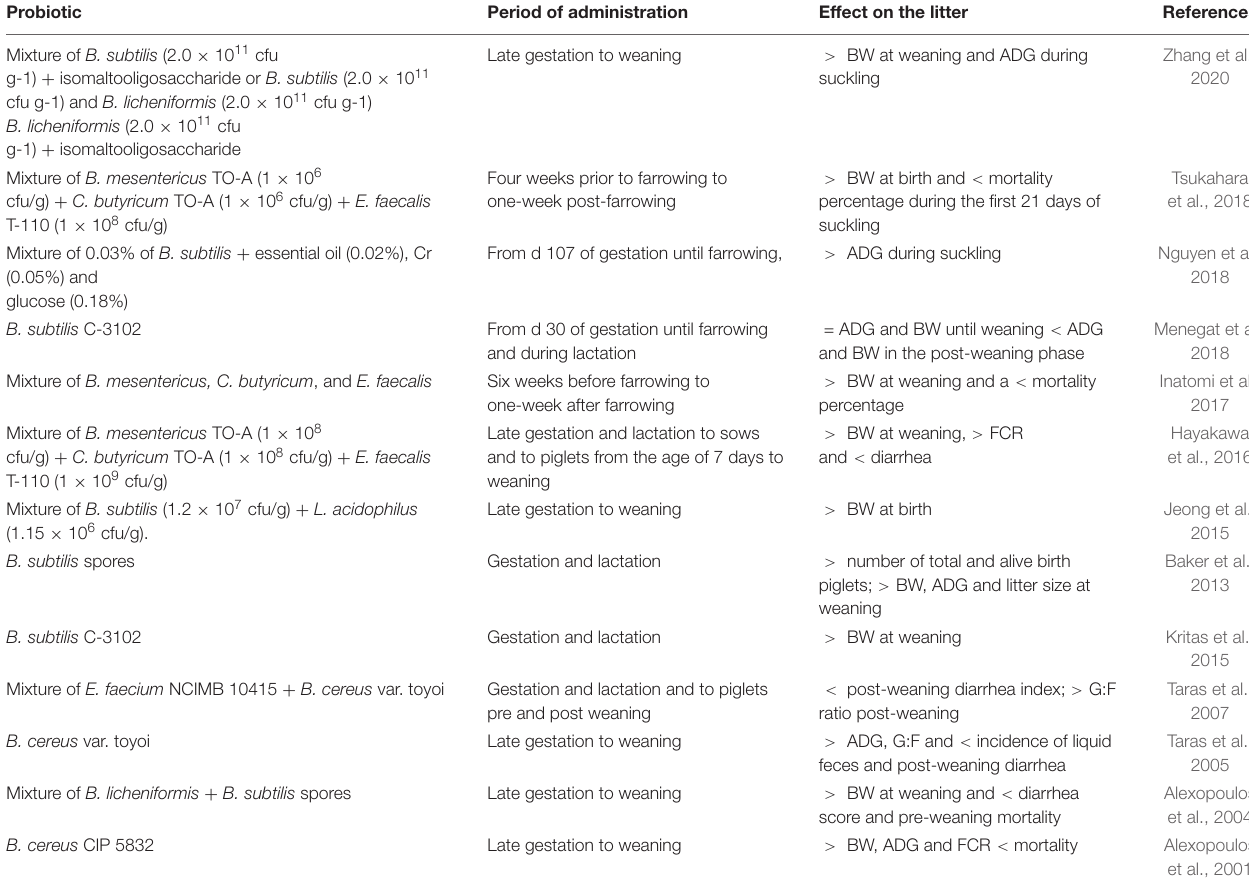
TABLE 2 | The effect of Bacillus probiotics on sow productive performance. Probiotic Period of